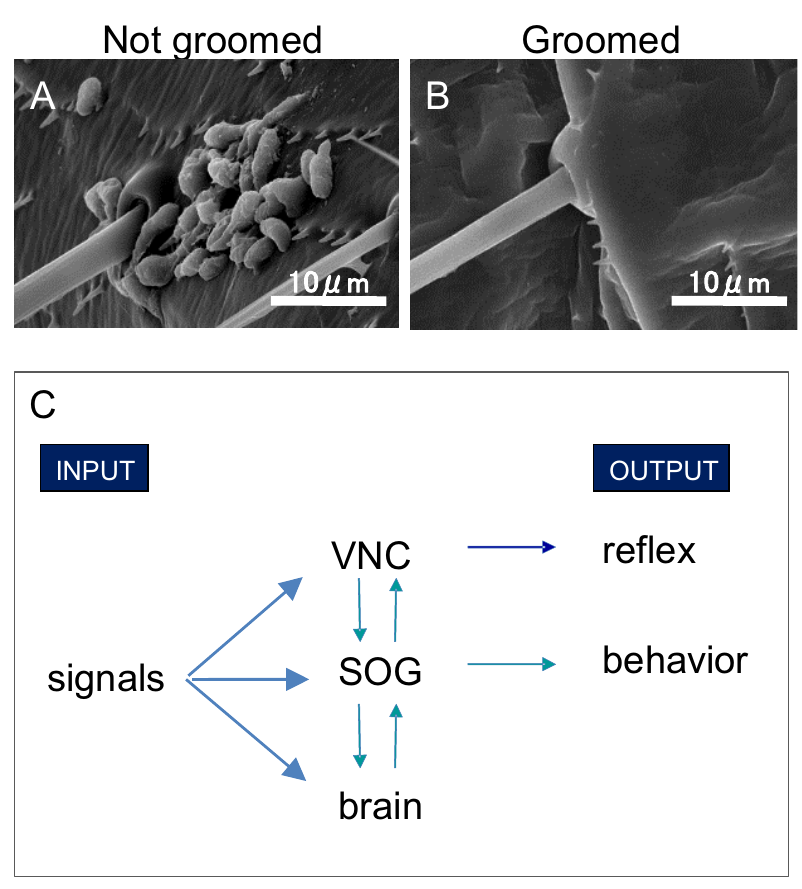
Figure 1. Scanning electron microscope images of nongroomed and groomed abdomen of Coptotermes formosanus . Pathogenic conidia completely cover the bases of sensilla ( A ), groomed abdomen have no conidium on their surface ( B ). ( C ) is the basic scheme of neural circuit of insect grooming. SOG is suboesophageal ganglion. VNC is ventral nerve